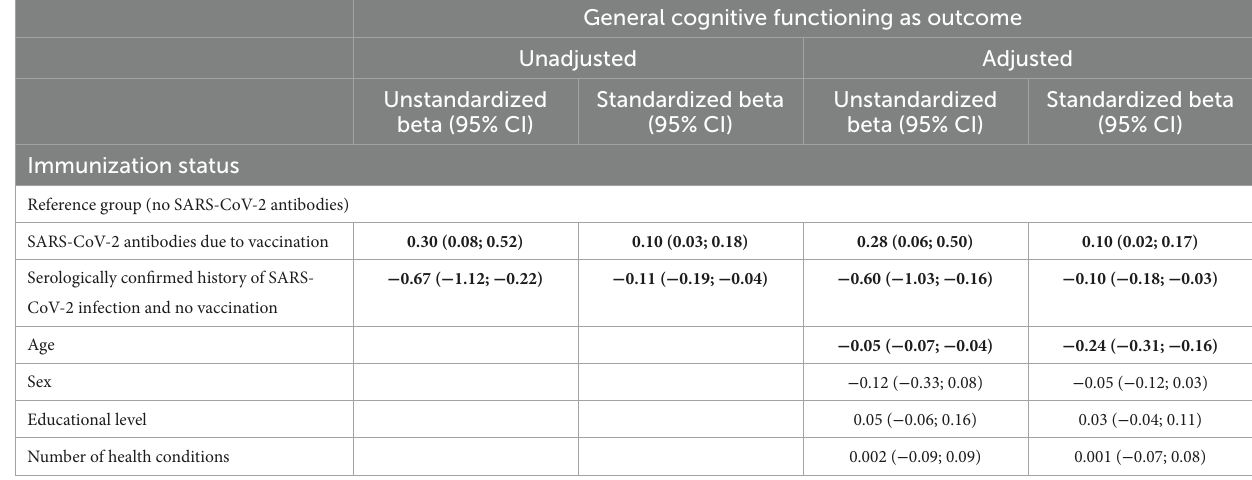
TABLE 3 Infection status as predictor of general cognitive